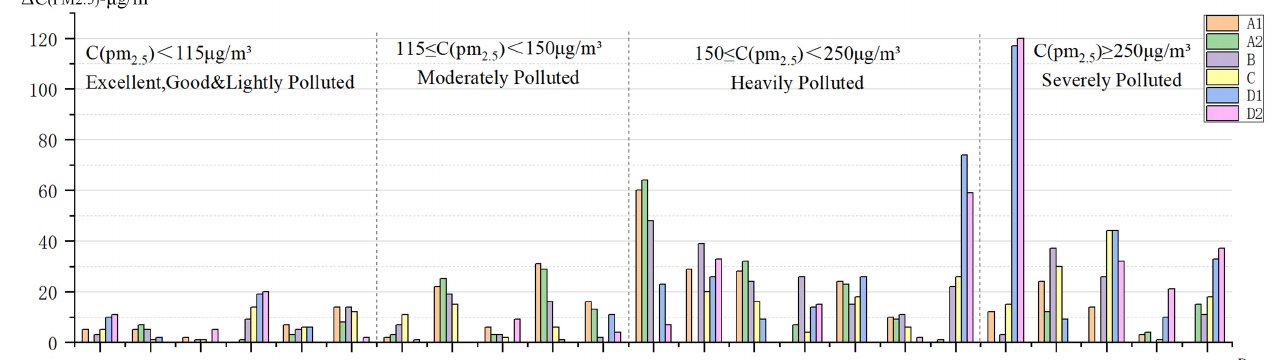
Figure 3. Comparison of difference values of PM2.5 concentrations.